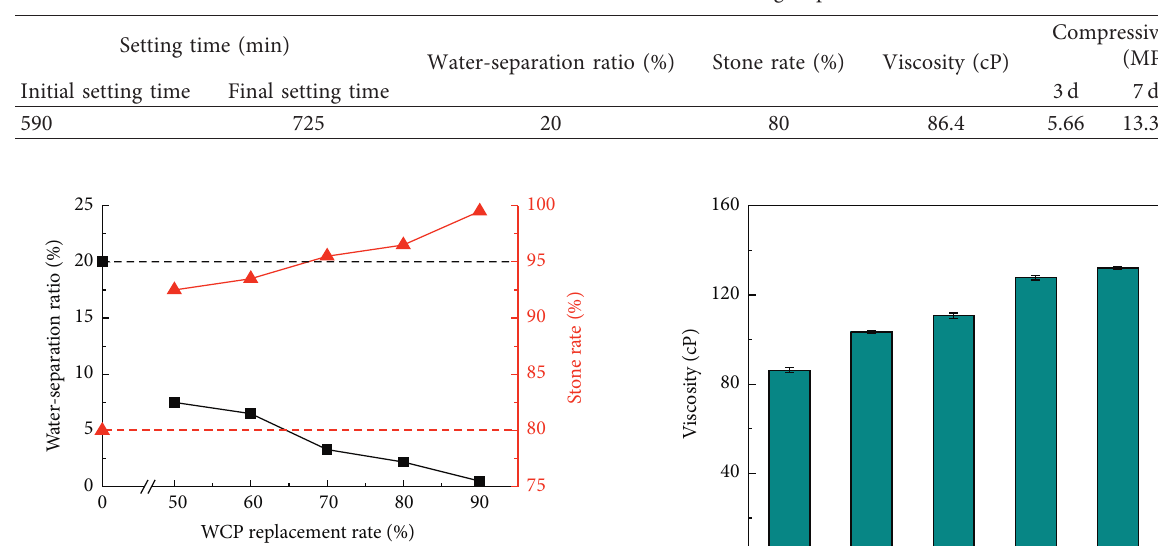
Table 4: Test results of the control group.